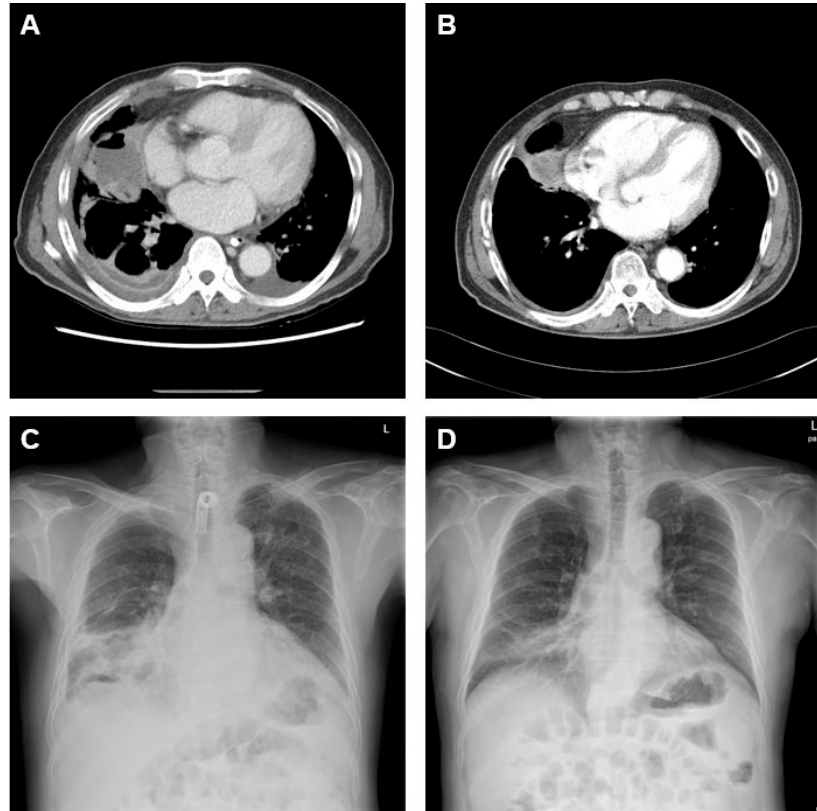
Figure 3. Serial changes in the patient’s chest CT and X-ray findings after discharge. A comparison of CT scans taken ( A ) at discharge and ( B ) 3 months later revealed significant improvement. A comparison of the chest X-rays taken ( C ) at discharge and ( D ) 3 months later showed that the abscess had disappeared.